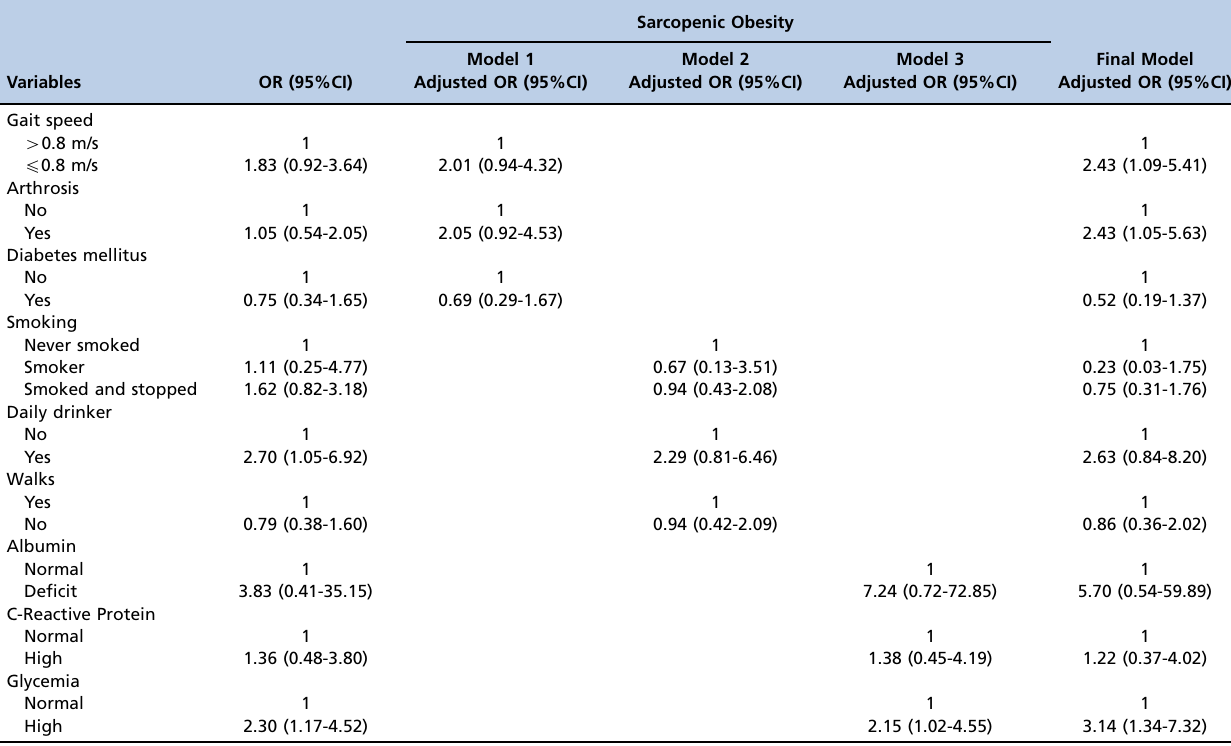
Table 4 - Crude and adjusted odds ratios (OR) and respective 95% confidence intervals (95%CI) for the association between sarcopenic obesity and functional variables and morbidities, lifestyle and biomarkers (FIBRA-RJ